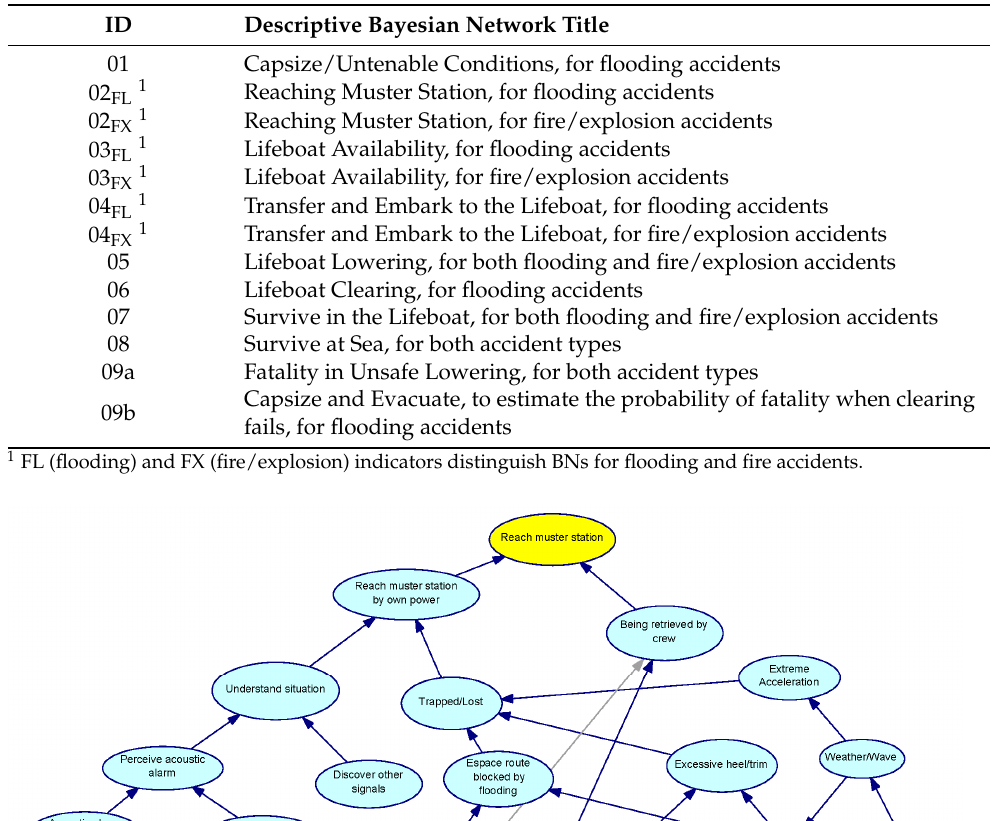
Table 1. The final list of Bayesian networks that are considered for the risk model.